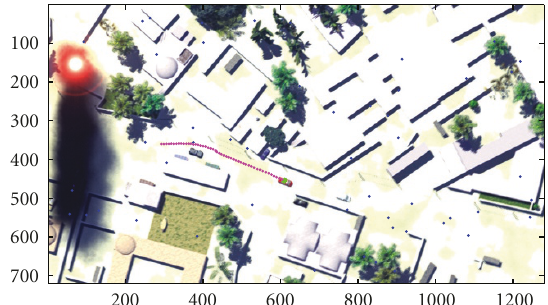
Figure 4: Green and blue dots show the sampling for the visible target and occluded target/background histogram, respectively. Magenta dots show the true target path projected onto current video frame.